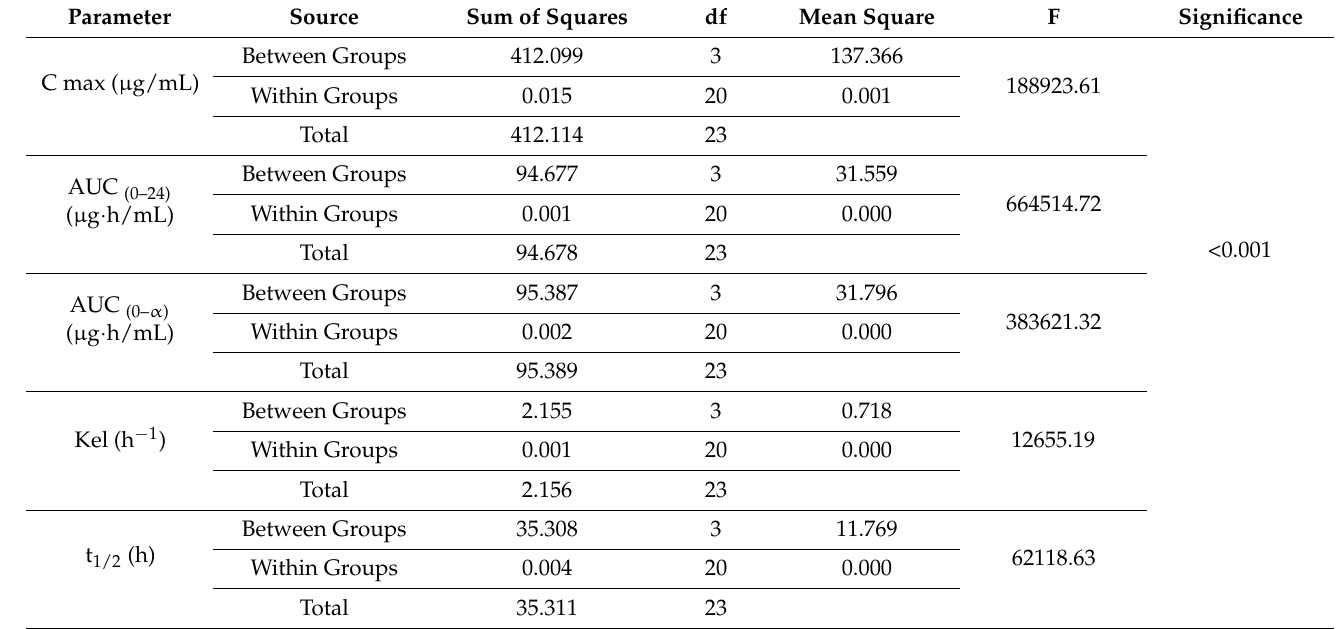
Table 7. One way ANOVA test for NIC pharmacokinetic plasma data following IN and IV administration from NLC formulation and solution in